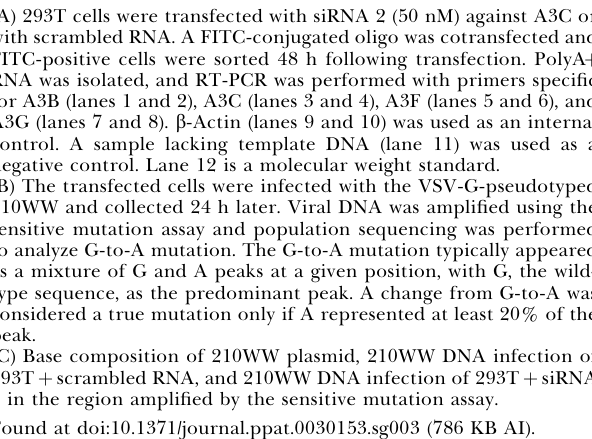
Figure S2. Amino Acid Alignment of 210WW, 210MM, NL4–3, and LAI Viruses (A) Gag amino acid alignment of 210WW, 210MM, NL4–3, and LAI viruses. Amino acid position relative to polyprotein start in HXB2: 1– 513. Residue numbers for each line of sequence are provided. The dots indicate the residues that match. (B) Protease alignment of 210WW, 210MM, NL4–3, and LAI viruses. Amino acid position relative to polyprotein start in HXB2: 557–655. Found at doi:10.1371/journal.ppat.0030153.sg002 (500 KB AI). Figure S3. Partial Reduction of A3C Expression and G-to-A Mutation by siRNA 2 (A) 293T cells were transfected with siRNA 2 (50 nM) against A3C or with scrambled RNA. A FITC-conjugated oligo was cotransfected and FITC-positive cells were sorted 48 h following transfection. PolyA þ RNA was isolated, and RT-PCR was performed with primers specific for A3B (lanes 1 and 2), A3C (lanes 3 and 4), A3F (lanes 5 and 6), and A3G (lanes 7 and 8). b -Actin (lanes 9 and 10) was used as an internal control. A sample lacking template DNA (lane 11) was used as a negative control. Lane 12 is a molecular weight standard. (B) The transfected cells were infected with the VSV-G-pseudotyped 210WW and collected 24 h later. Viral DNA was amplified using the sensitive mutation assay and population sequencing was performed to analyze G-to-A mutation. The G-to-A mutation typically appeared as a mixture of G and A peaks at a given position, with G, the wild- type sequence, as the predominant peak. A change from G-to-A was considered a true mutation only if A represented at least 20% of the peak. (C) Base composition of 210WW plasmid, 210WW DNA infection of 293T þ scrambled RNA, and 210WW DNA infection of 293T þ siRNA 2 in the region amplified by the sensitive mutation